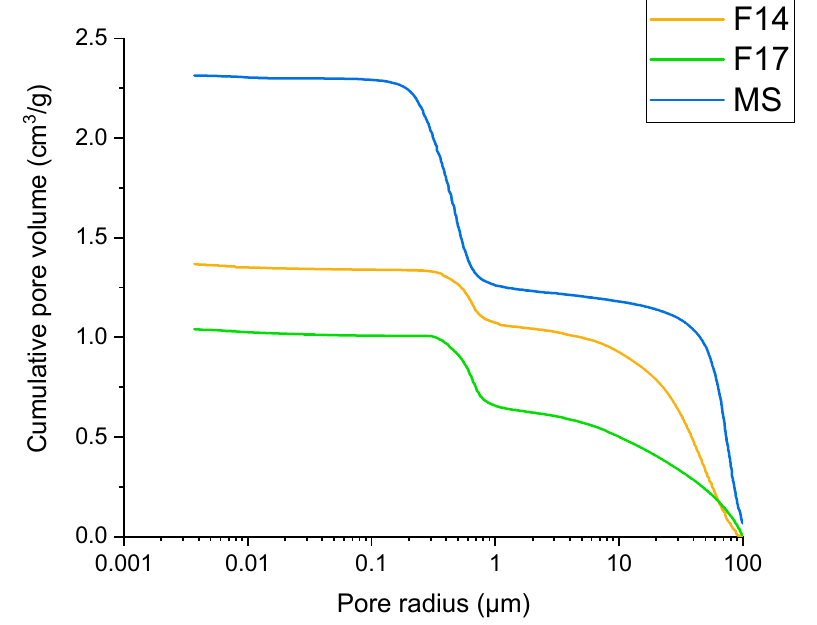
Figure 9. Dependency of cumulative pore volume on pore size as determined by mercury intrusion porosimetry for pure MS (blue line), experiment F14 (orange line) and experiment F17 (green line). Only the intrusion of mercury for a pore size under 1 µm is relevant for the intra- particulate pore space (Figure 9).